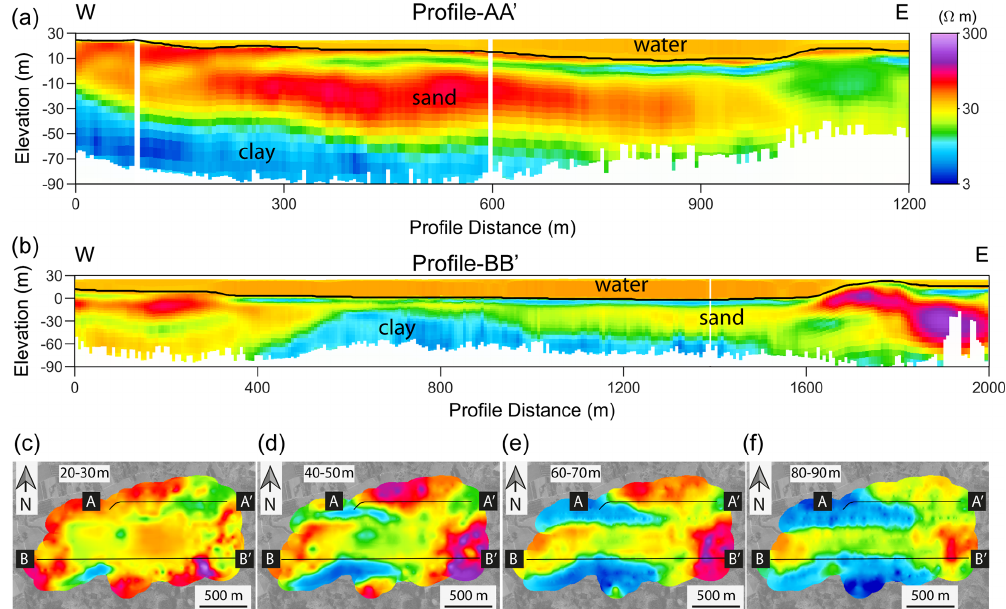
Figure 7. Results from Ravnsø FloaTEM survey. Panels (a) and (b) show the resistivity model along profiles AA (cid:48) and BB (cid:48) , respectively; the locations of profiles AA (cid:48) and BB (cid:48) are marked in Fig. 6. The black line in the sections marks the lake bottom, while the white faded colors indicate the DOI. Panels (c) – (f) show mean resistivity maps at four depth intervals below surface together with locations of profiles AA (cid:48) and BB (cid:48) .